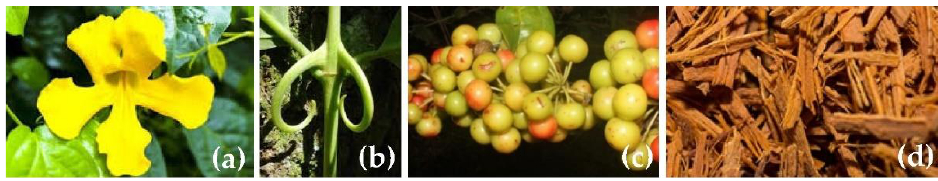
Figure 1. ( a ) Flowers, ( b ) stem with nail-shaped spines, ( c ) fruits, and ( d ) bark of Uncaria tomentosa .